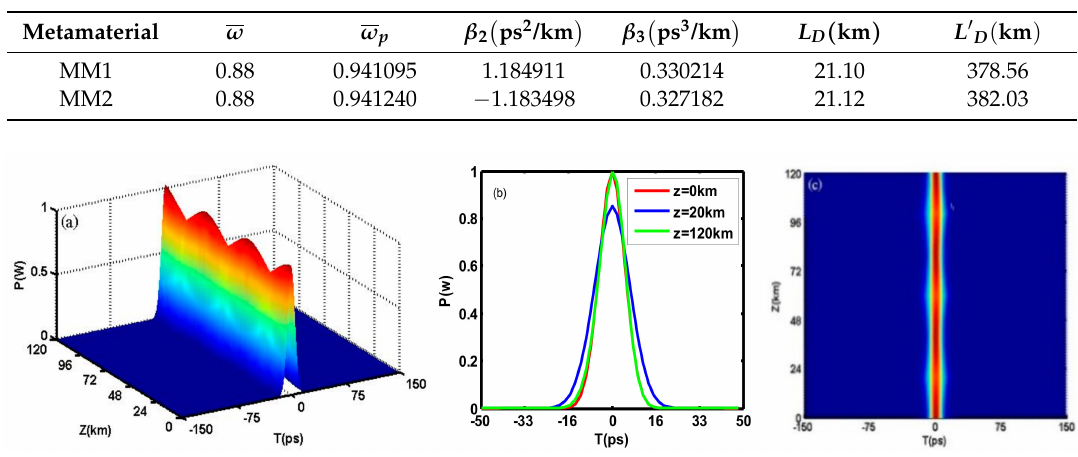
Table 5. Two sets of data for β 2 compensation with ω pe = 3.3673 × 10 16 Hz.